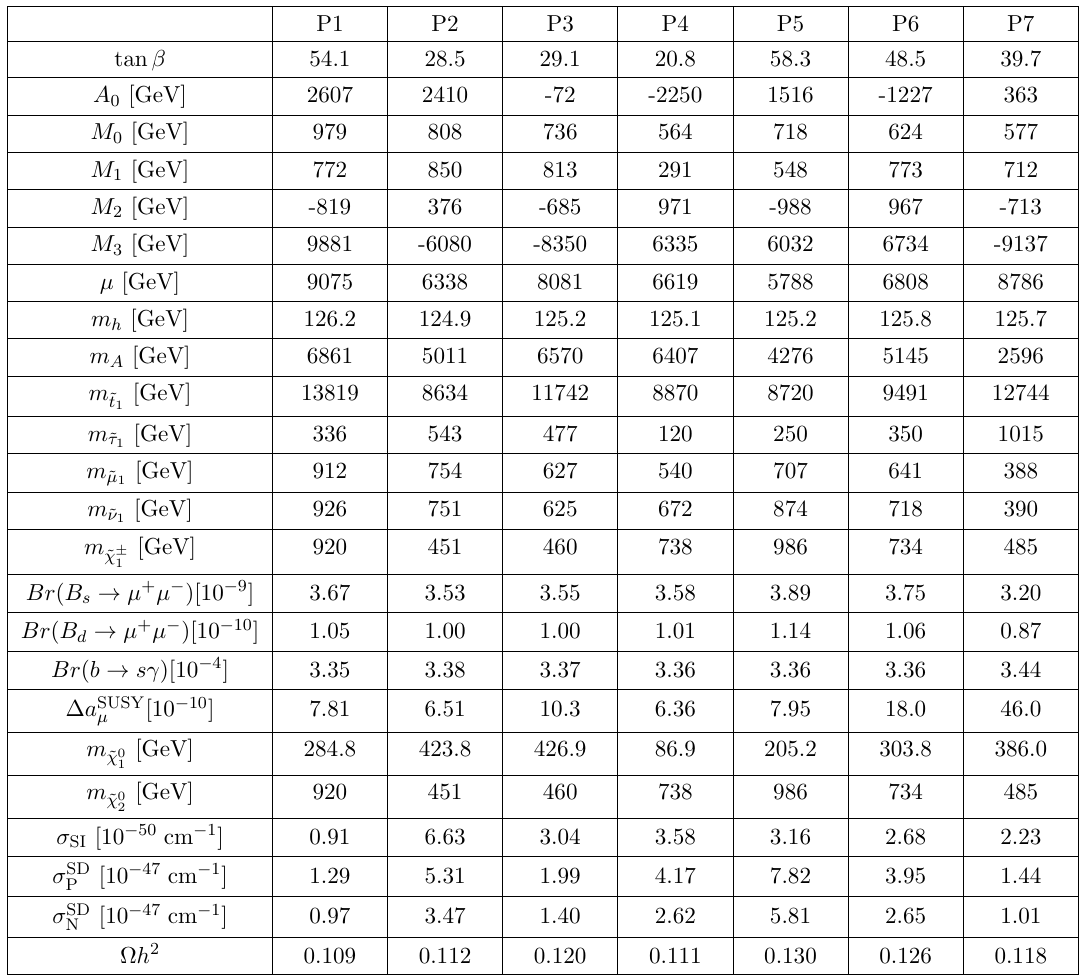
Table 3 . The detail information of the 7 benchmark